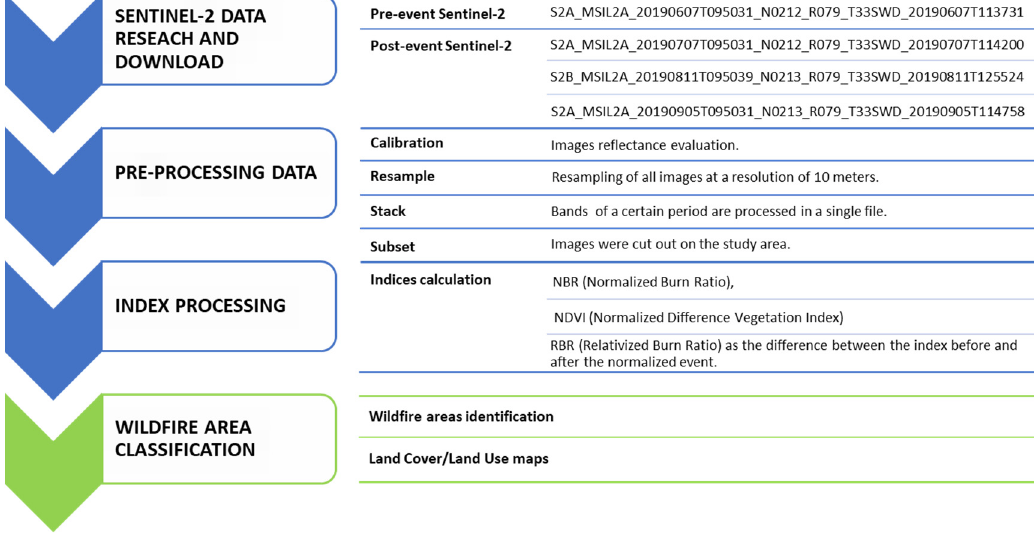
Figure 3. Flowchart summarizes the image processing procedure for the wildfire impact and severity mapping. severity